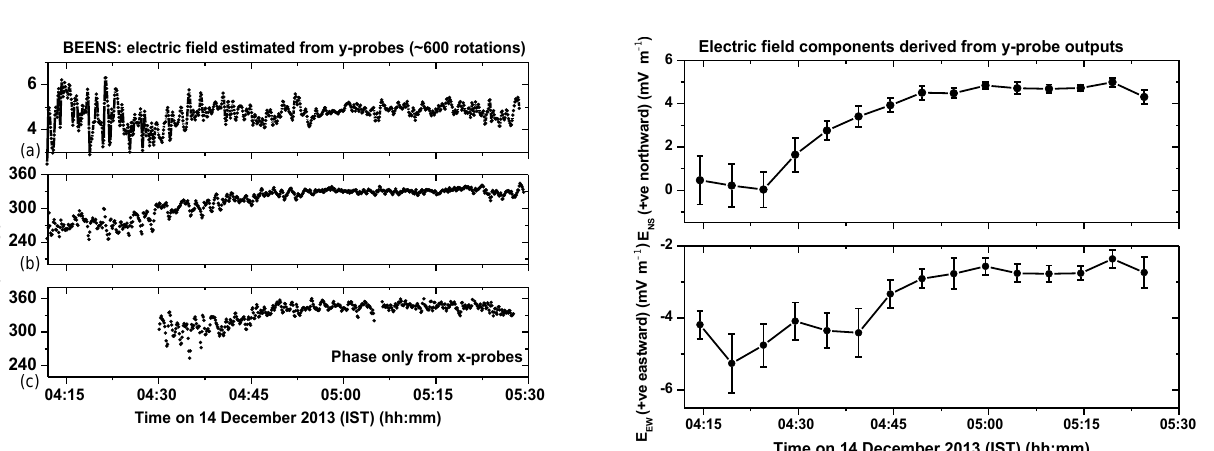
Figure 14. The magnitude and direction ( a, b , respectively) of hor- izontal electric field at stratospheric altitudes derived from y probes obtained from every payload spin duration between 04:12 and 05:30IST. In the bottom panel, the phases derived from x probes are also shown for comparison. Data from the x probes prior to 04:30IST were noisy and phase estimates for those times are not shown.